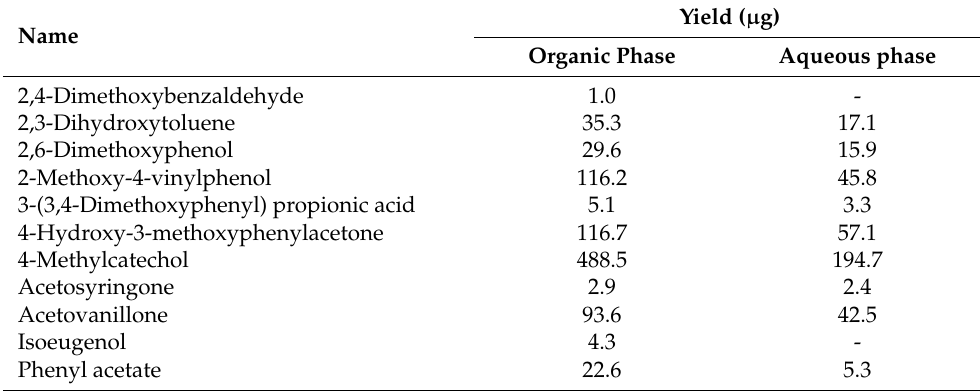
Table 4. The predominant products from hydrogenolysis of